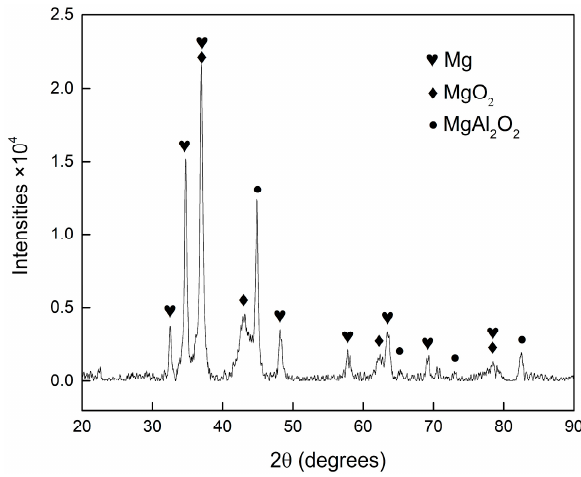
Figure 11. The measured X-ray diffractogram of the debris of surfacing alloys with 1.5% Ce after sliding.